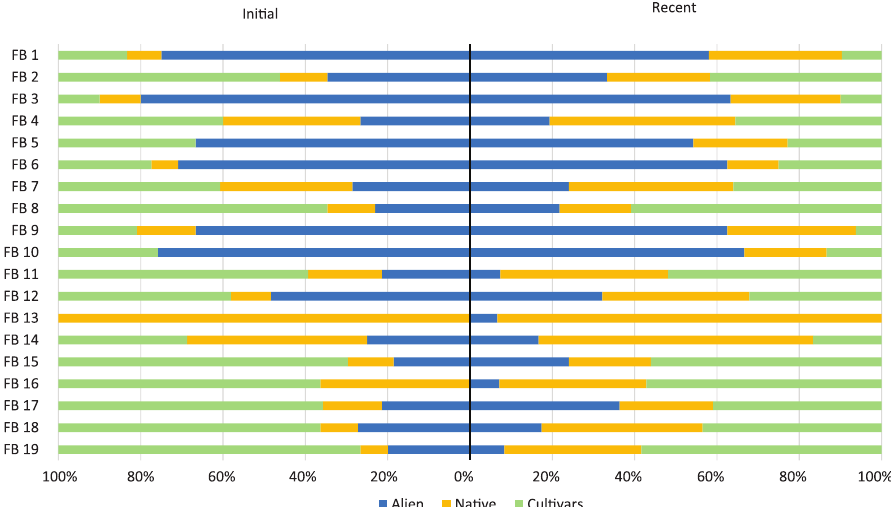
Figure 1. Percentage of taxa present in each flowerbed separated according to initial vs recent ornamental assemblages. In addition, the colored bars are indicative of taxa classified according to their status (i.e. alien; native; cultivars) in the Czech Republic. Some FB (no. 13, 16) were established with exclusively native taxa or their varieties. In the recent assemblages all FB harboured alien